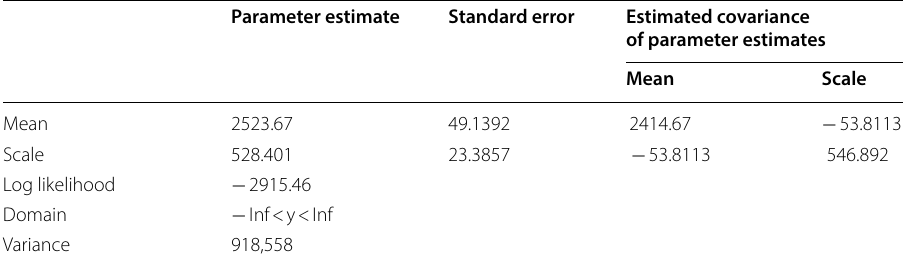
Table 3 Logistic distribution fitting model parameters for the internet download